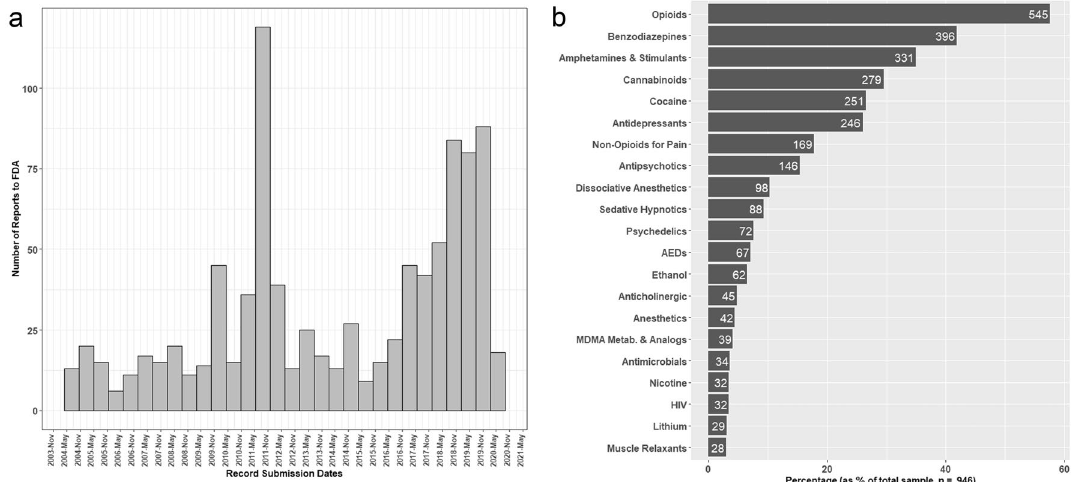
Figure 1. Dates of MDMA reports to FDA FAERS and frequency of reports of concomitant medications. ( a ) Histogram illustrating number of reports sent to FDA FAERS that included MDMA as a medication. Histogram bars are binned in 6-month periods. Note that reports prior to 2004 are all counted as occurred in Q1 2004. ( b ) Frequency of occurrence of one or more concomitant drugs from each individual drug class. Number of reports shown on the right side of each